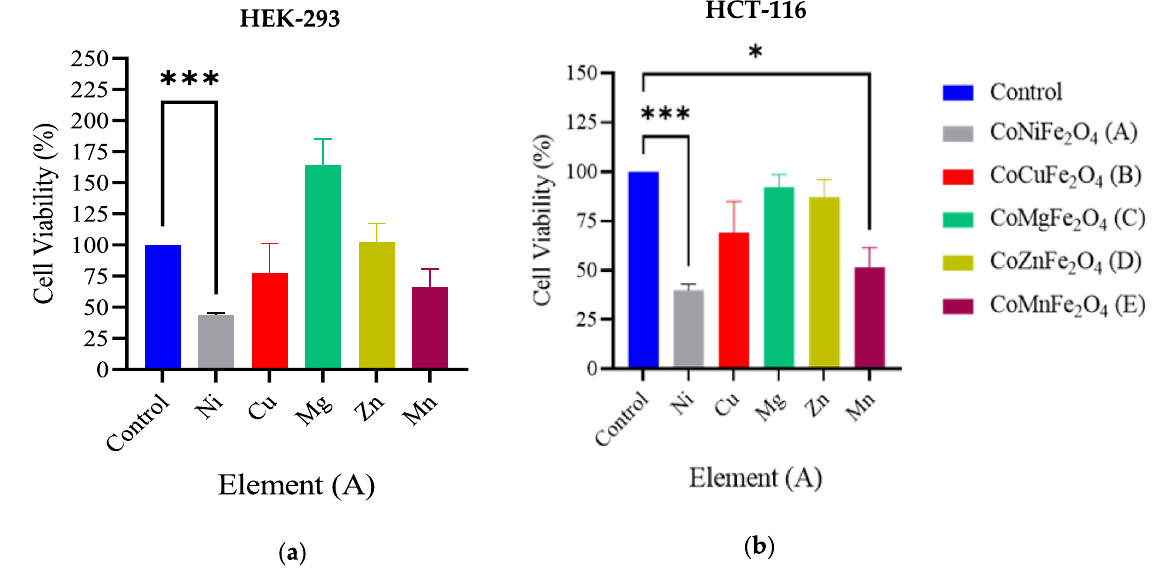
Figure 6. The average cell viability of ( a ) HEK-293 and ( b ) HCT-116 cell lines by MTT assay. Cells were treated with the following conditions CoMFe